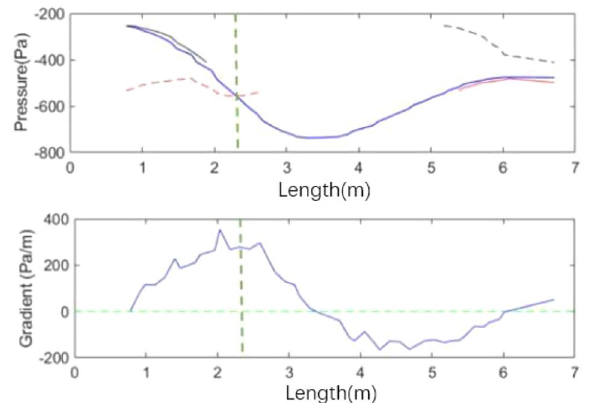
Figure 21. Vortex pressure variation curve (the green vertical line on the right represents the time when the pressure values of red line vortex and blue line vortex are